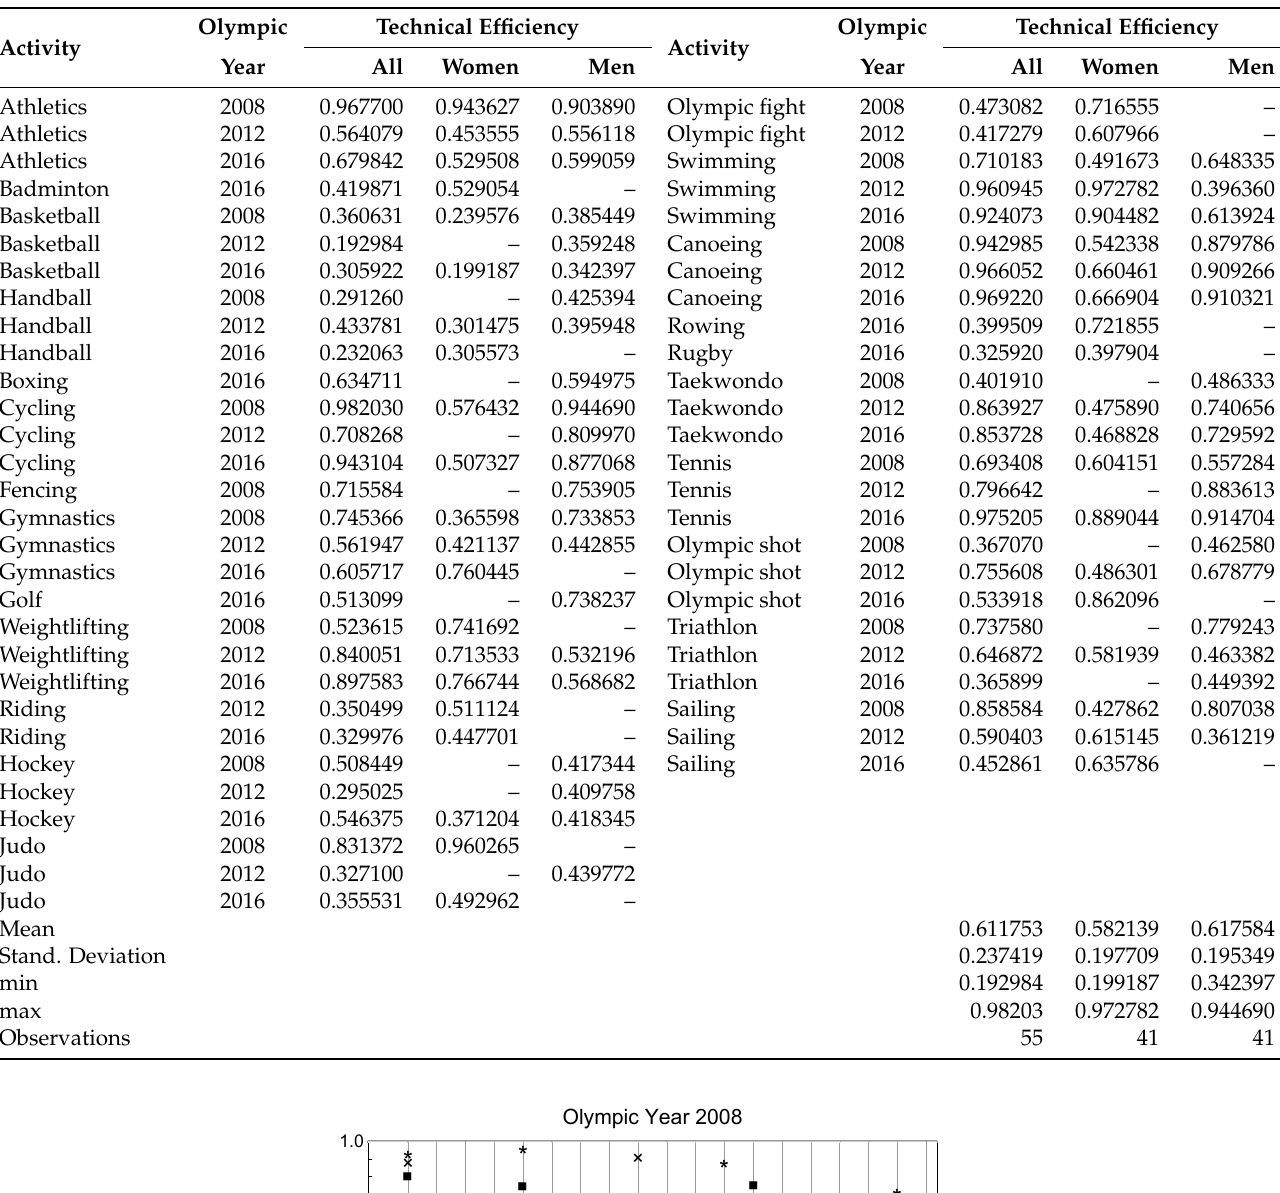
Table 7. Technical efficiency for all, women, and men (2008, 2012, and 2016) based on data provided in Table 5. Activity